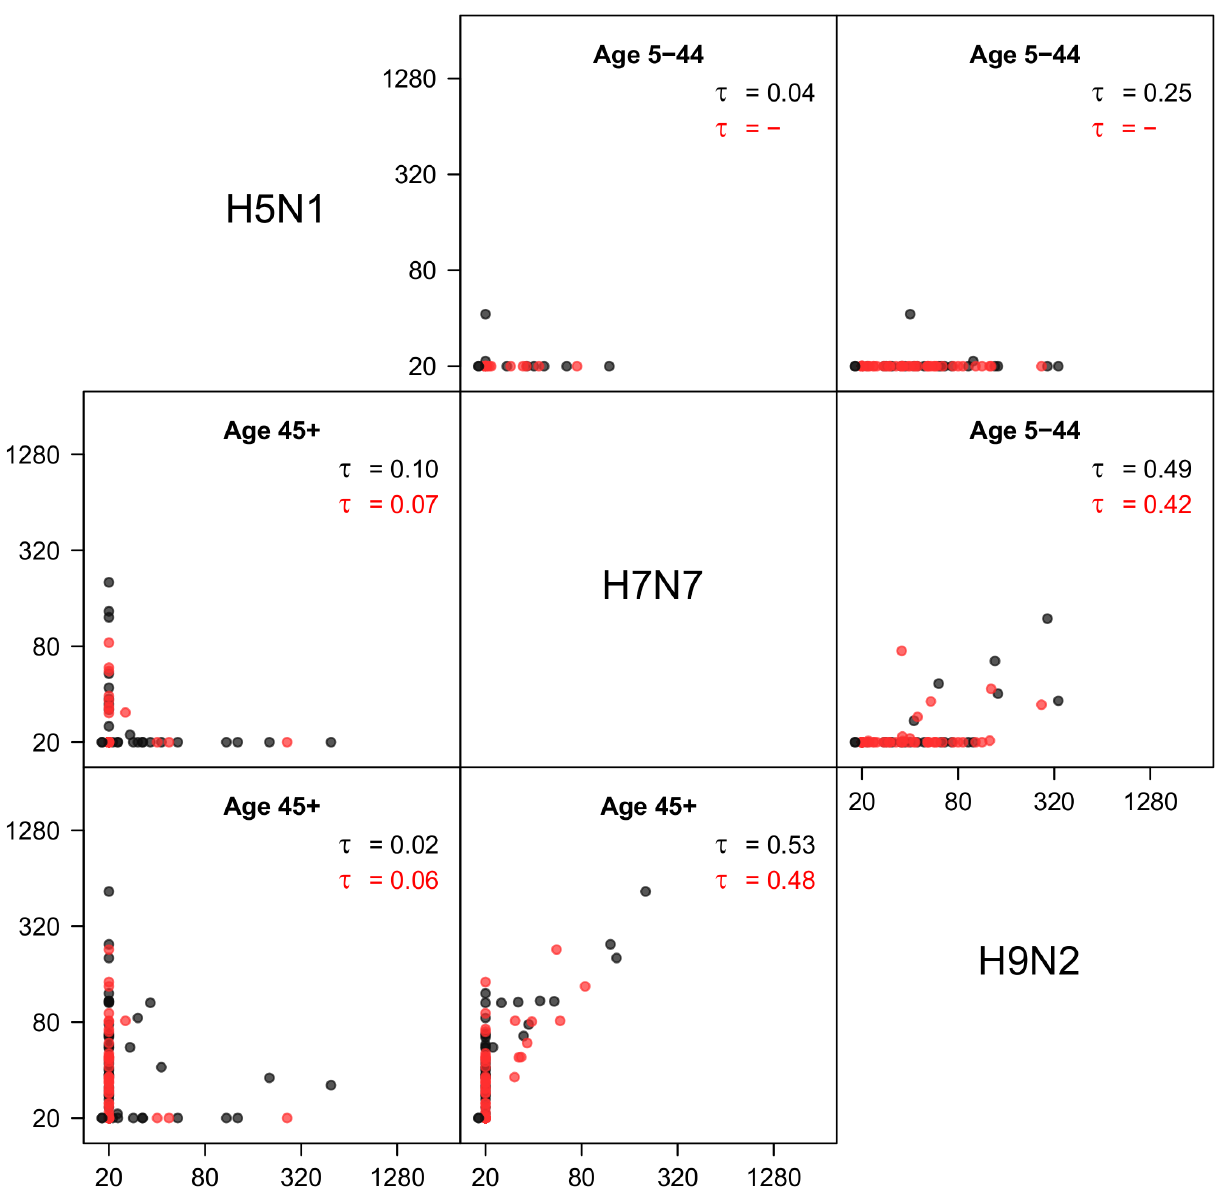
Fig 4. Correlations of antibody responses to avian influenza A viruses. Results are given for age groups 5-44 years (above the diagonal)and 45+ years (belowthe diagonal).Black dots: pre-pandemic survey; red dots: post-pandemic survey. In each panel, Kendall’stau is given for the pre- and post-pandemics surveys (black and red). Notice that all personswith positive H7N7 responsealso have a positive H9N2 response. Antigens includedare from viruses A/Vietnam/1194/2004(H5N1), A/Chicken/Netherlands/1/2003 (H7N7), and